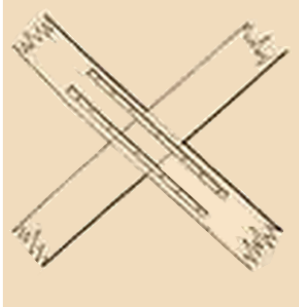
Figure 4: Detail of intrados connection of the Corbeil